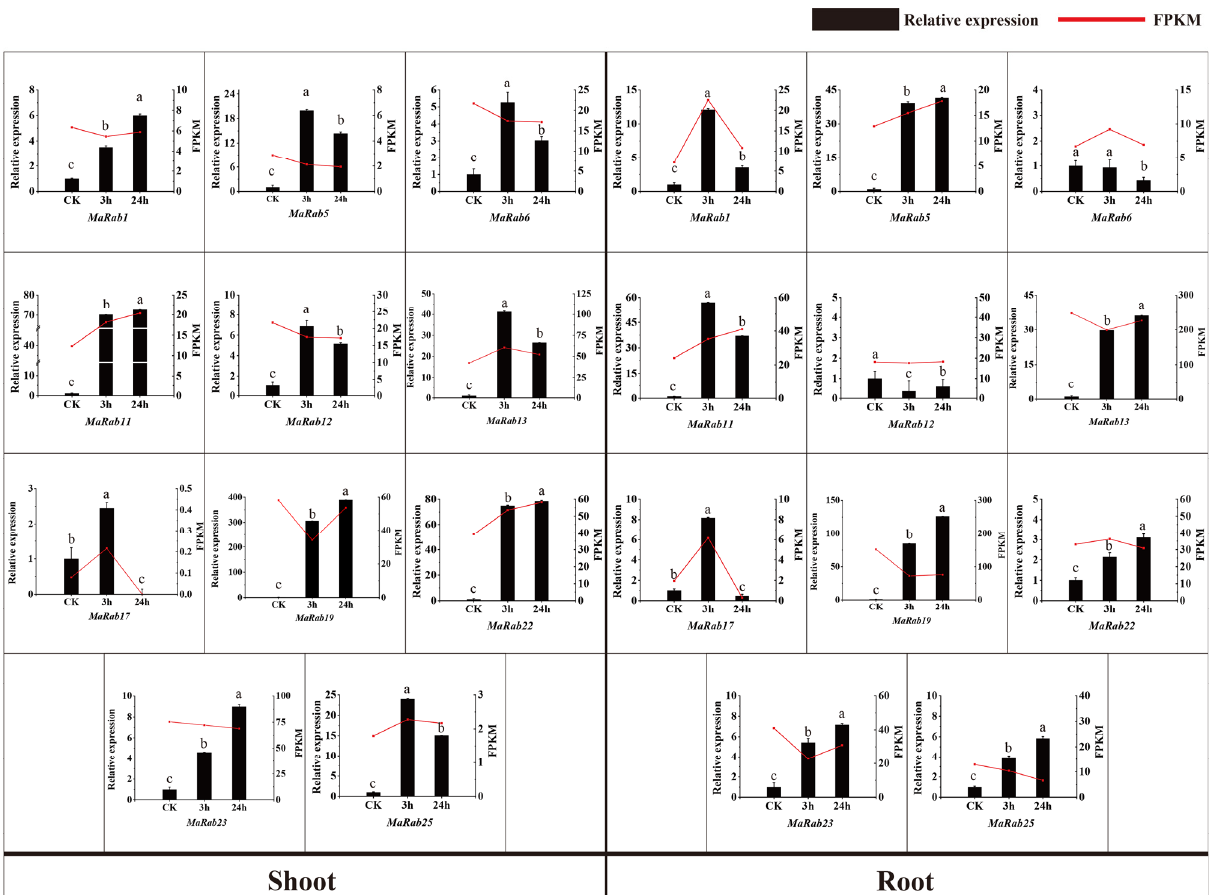
Figure 8. Gene expression of eight MaRabs in shoots and roots under NaCl treatments using qRT − PCR. Different small letters above the columns indicate significant ( p ≤ 0.05) differences between various treatments. The control is represented by CK. The red lines represent the expression values (FPKM) from RNAseq data, and the values given are the mean ± standard deviations of three replicates.